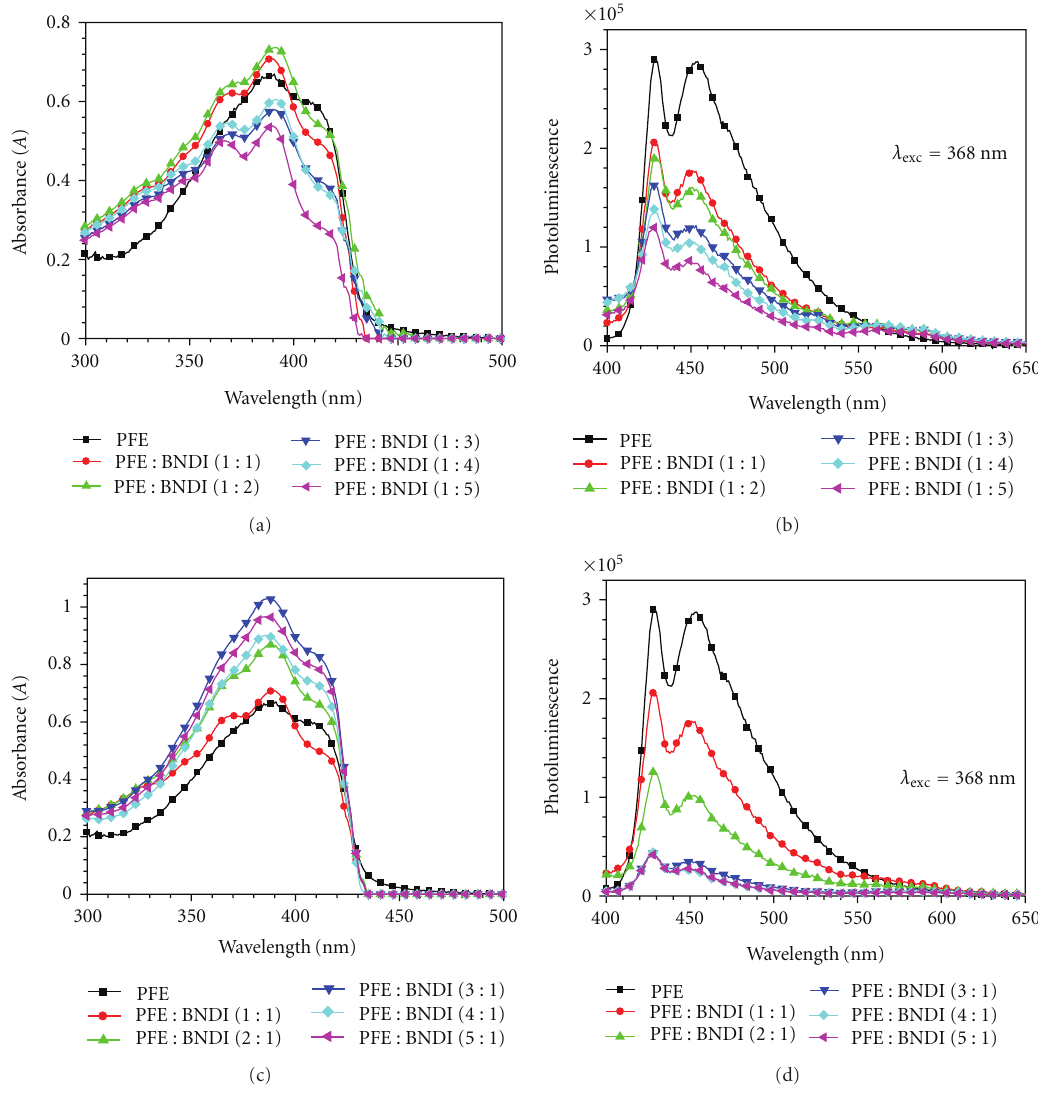
Figure 4: Absorption and photoluminescence spectra of (a) and (b) PFE:BNDI (1:1–5); (c) and (d) PFE: BNDI (1–5:1).